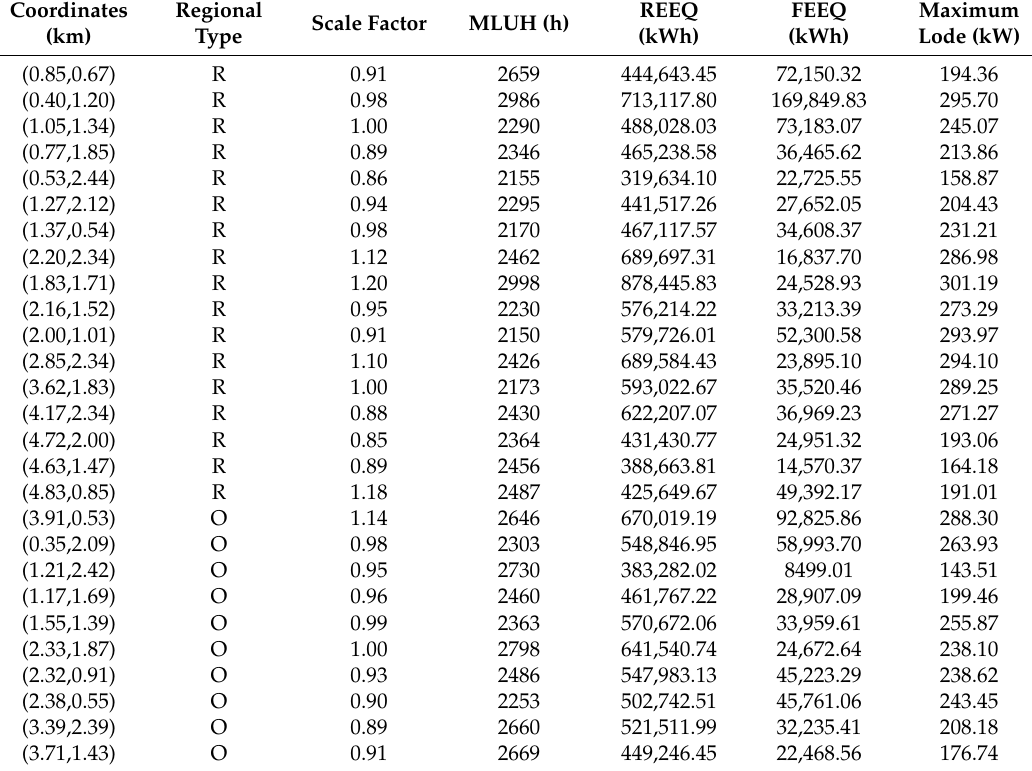
Table 4. The data of each